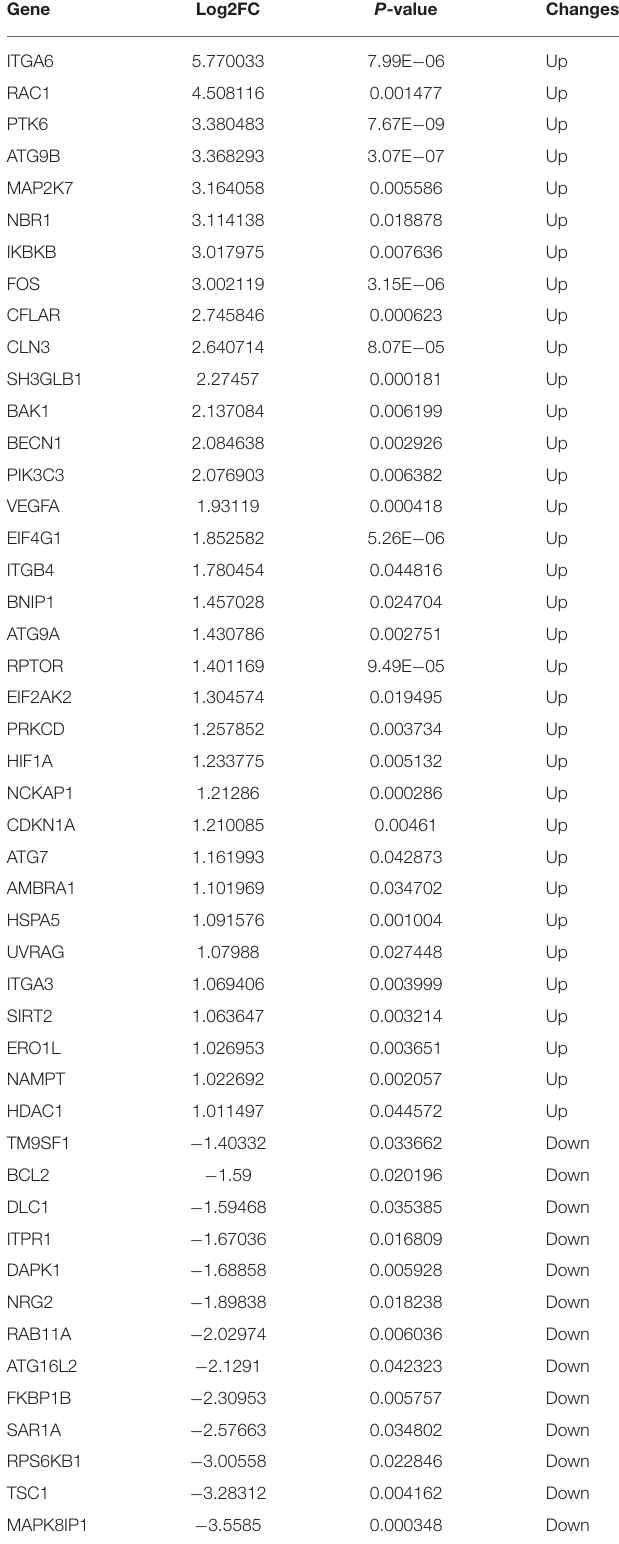
TABLE 1 | The 47 differentially expressed autophagy-related genes in experimental necrotizing enterocolitis (NEC). Gene